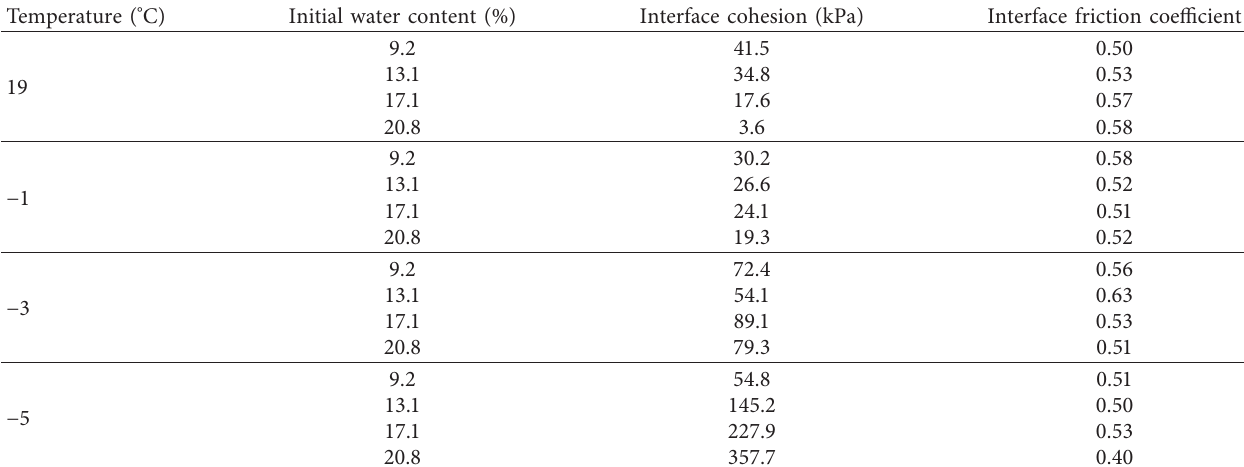
Figure 4: Relationship of the initial tangent stiffness with different water contents and normal stresses at a temperature of 19 ° C (a), –1 ° C (b), –3 ° C (c), and –5 ° C Table 2: Interface shear strength parameters.